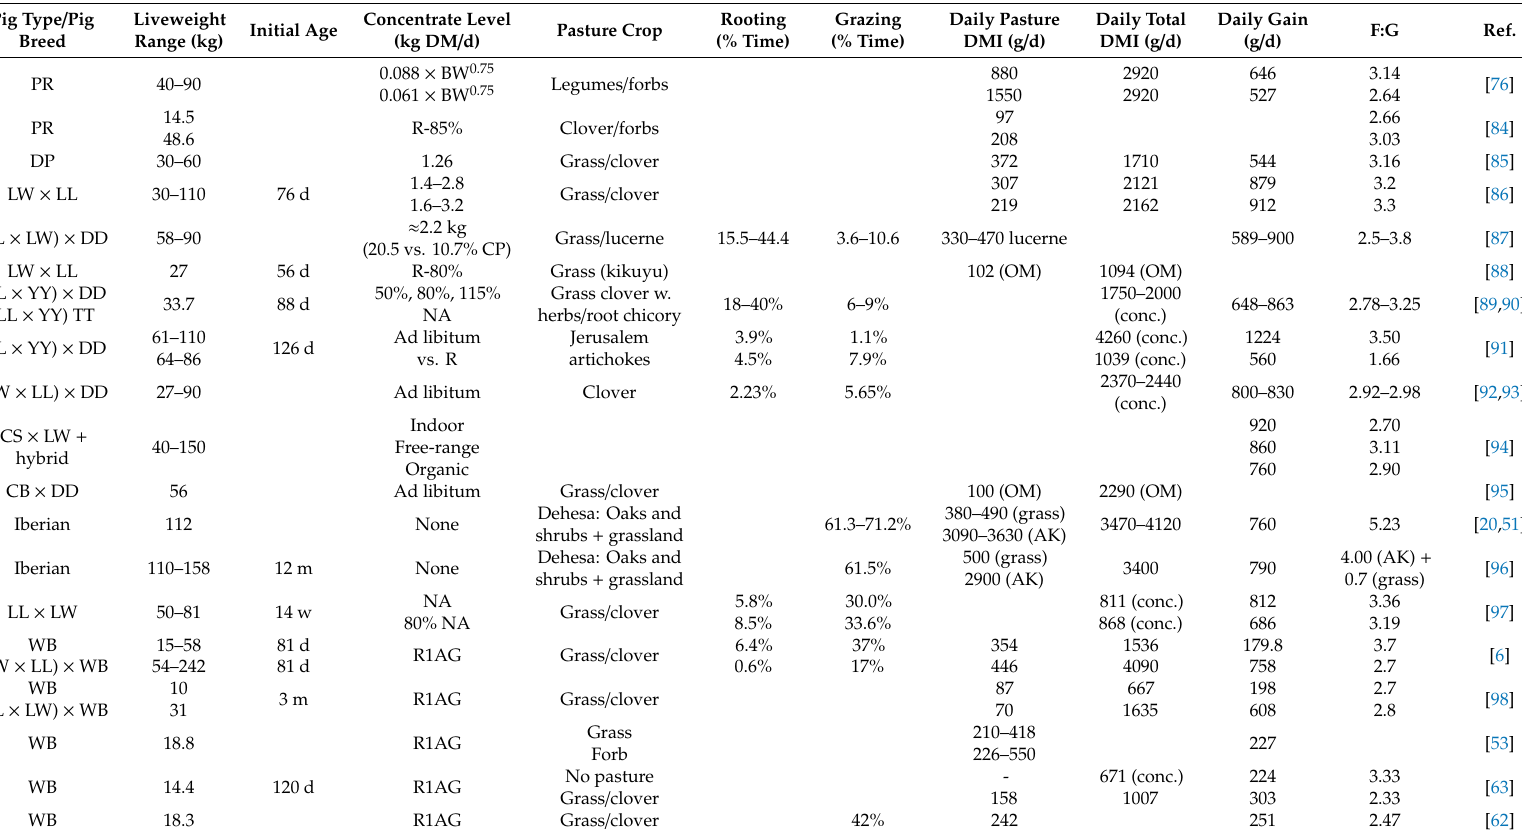
Table 1. Foraging behaviour and daily dry matter (DM) intake of wild boar and domesticated pigs with access to pasture (review of 22 studies from 2001 to 2018). Pig Type / Pig